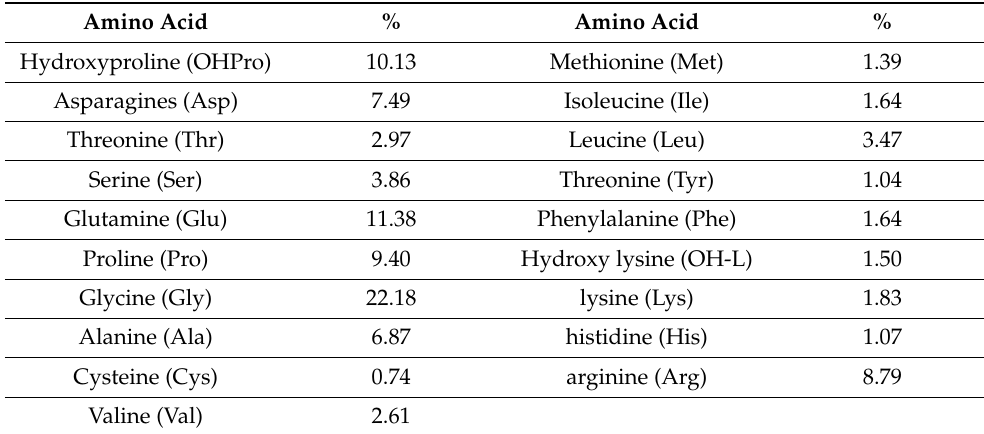
Table 1. Amino acid content in collagen from Dosidicus gigas